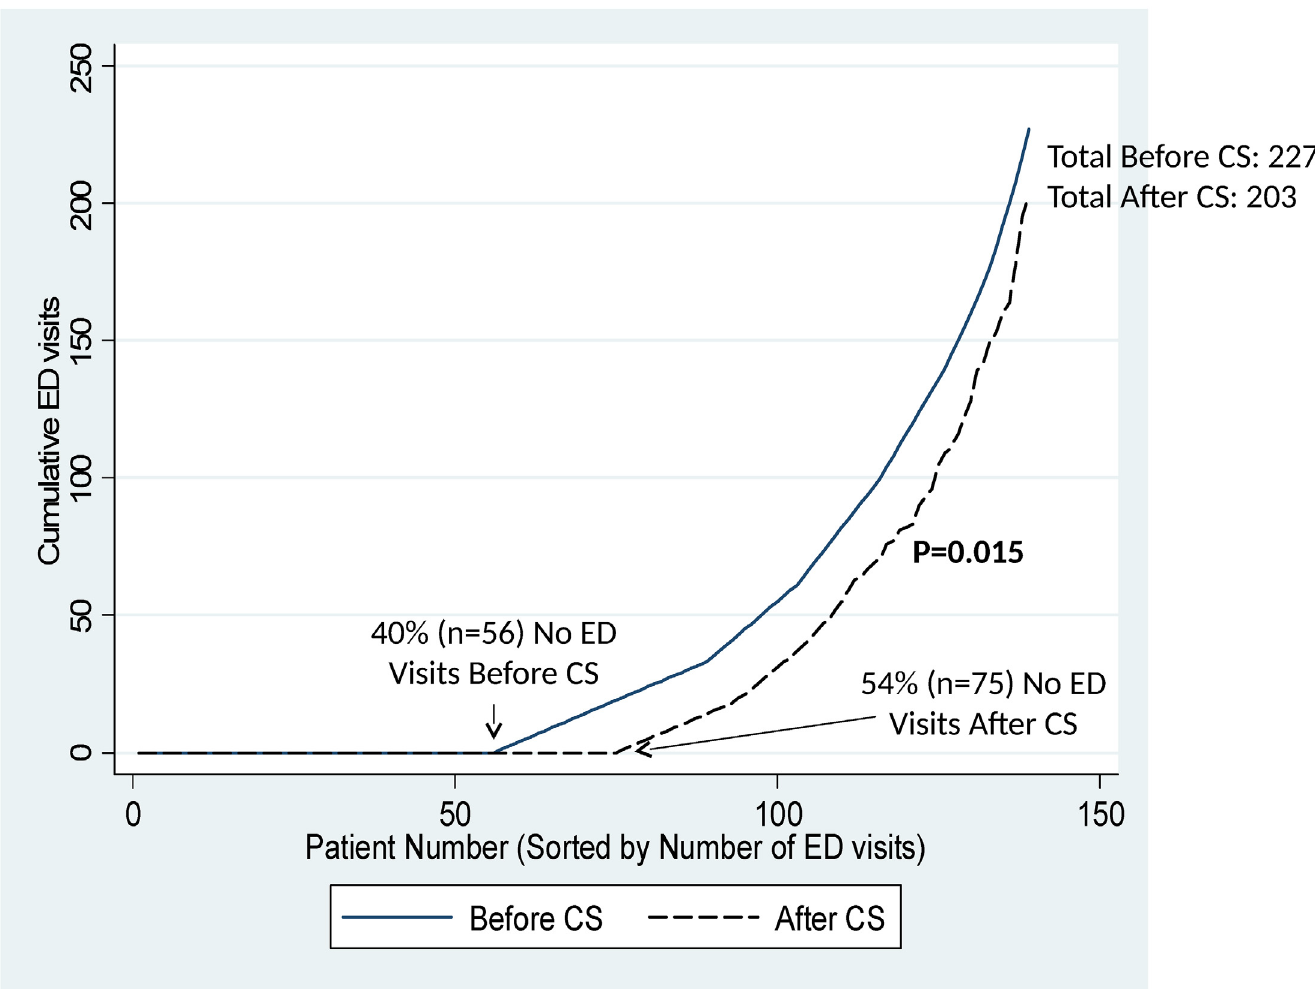
Fig 2. Cumulative Number of Emergency Department (ED) Visits in Care Support (CS) Patients Before and After Enrollment. The cumulative number of ED visits is shown as a function of patient number (sorted by number of ED visits) during the 6 months before enrollment in Care Support (solid line) and the 6 months after enrollment (dashed line). The proportion of patients with zero ED visits increased significantly from 40% pre-enrollment to 54% post- enrollment (McNemar ’ s test, p =